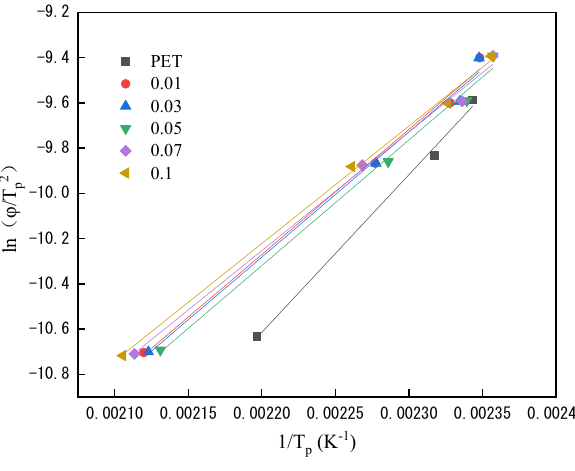
Figure 7. Kissinger plots of ln( Φ / T p 2 ) versus Tp −1. Table 5. The non-isothermal crystallization activation energy of PET by the Kissinger method.